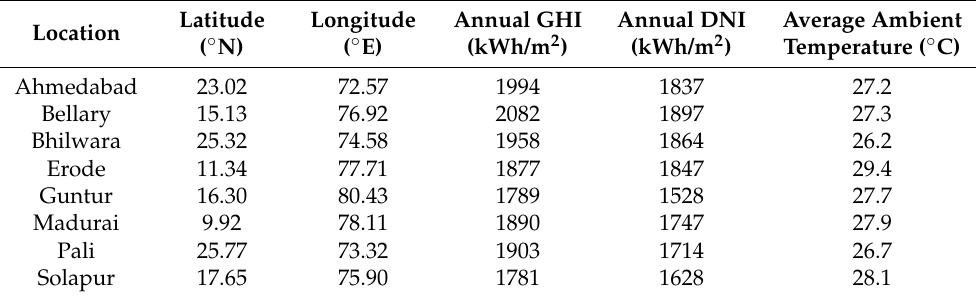
Table 1. Locations selected for the present study with corresponding annual average values of GHI, DNI, and ambient temperature (source: Meteonorm 8